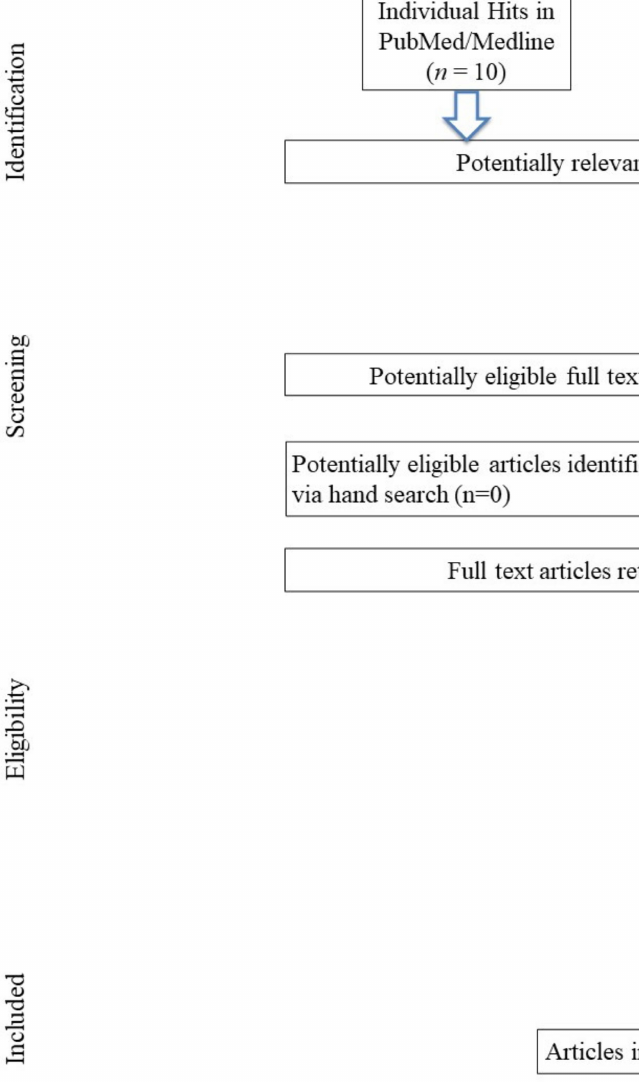
Figure 1. Study flow